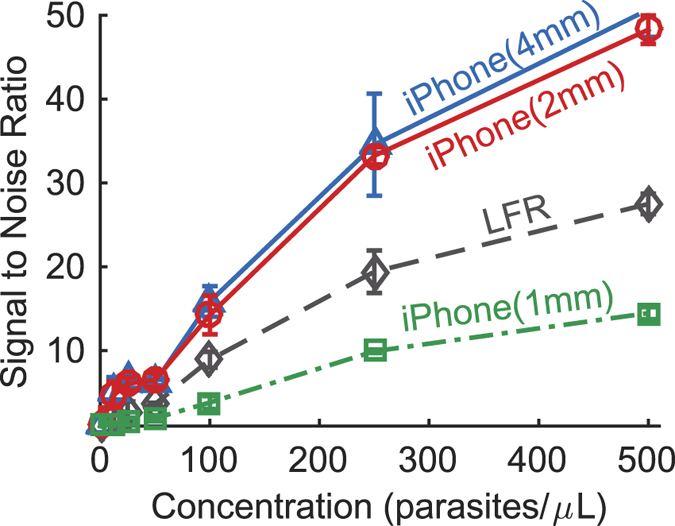
The signal to noise ratio of the integrated test peaks from the lateral flow reader and selected line scan widths (in parentheses) using the mobile phone.